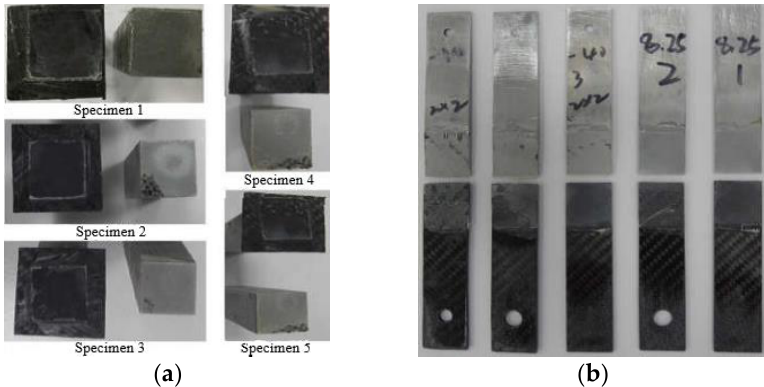
Figure 11. Specimen failure form: ( a ) Butt tensile specimen; ( b ) Lap shear specimen.